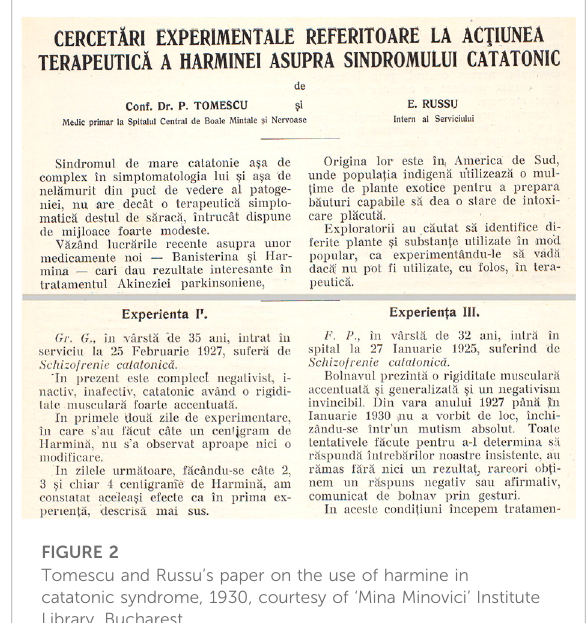
FIGURE 2 Tomescu and Russu ’ s paper on the use of harmine in catatonic syndrome, 1930, courtesy of ‘ Mina Minovici ’ Institute Library,